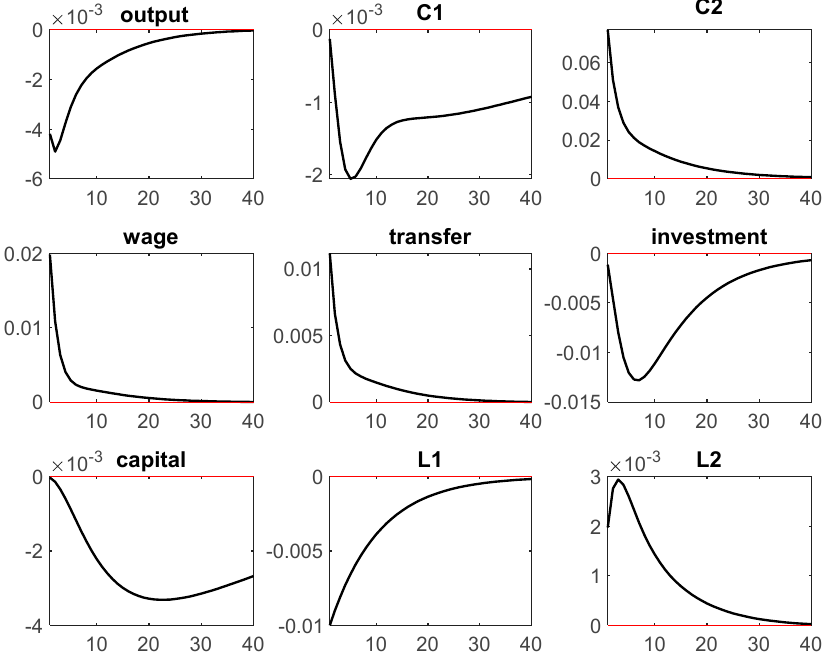
Figure 1. The effects of home productivity shock on key Korean macroeconomic variables.